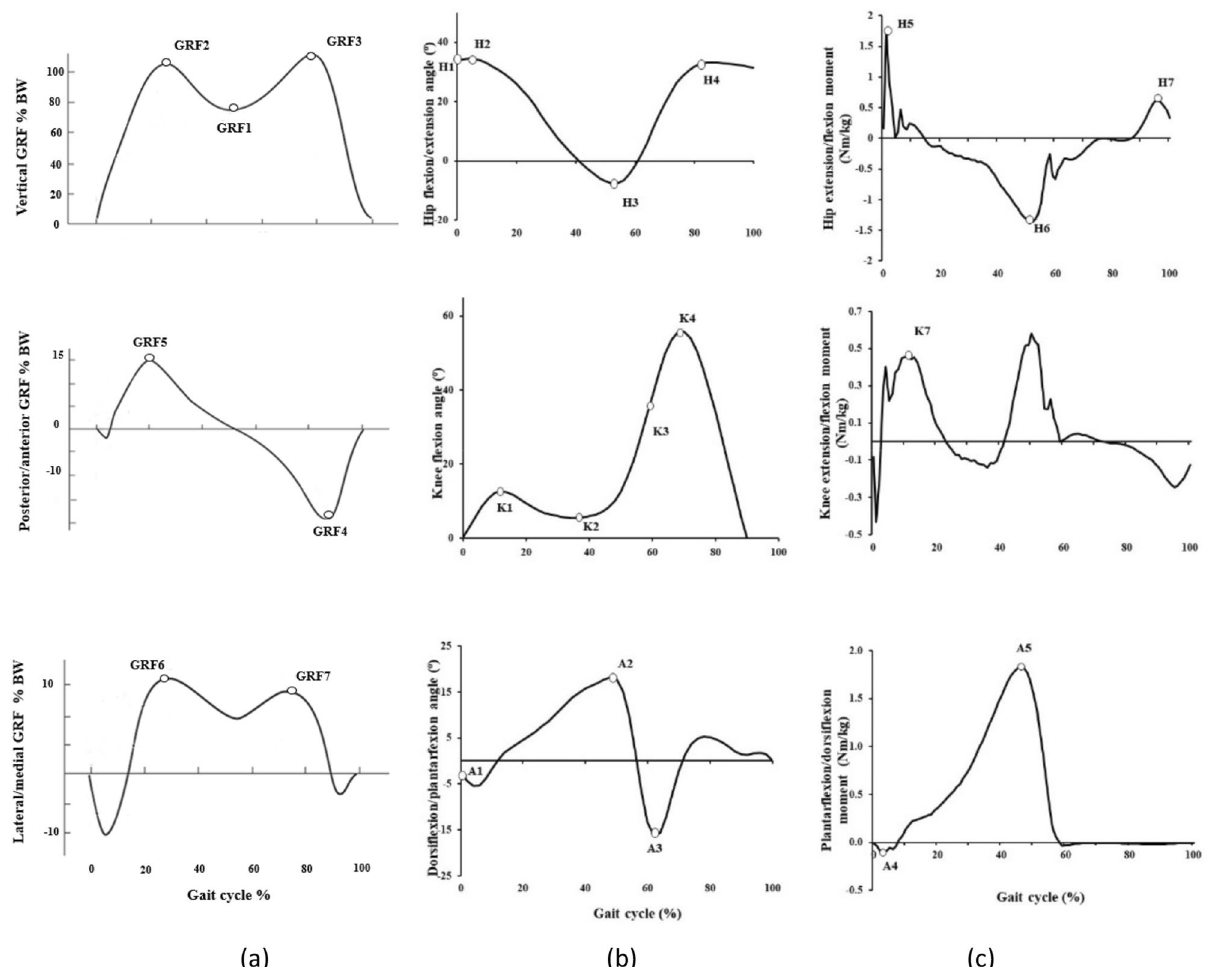
Figure 3. Three dimensional GRFs ( a ), sagittal plane kinematic ( b ) and kinetic ( c ) variables of interest during walking. Ankle dorsiflexion, knee flexion, hip flexion, anterior and medial GRFs, as well as internal ankle plantar flexion, knee extension and hip extension moments were all defined as